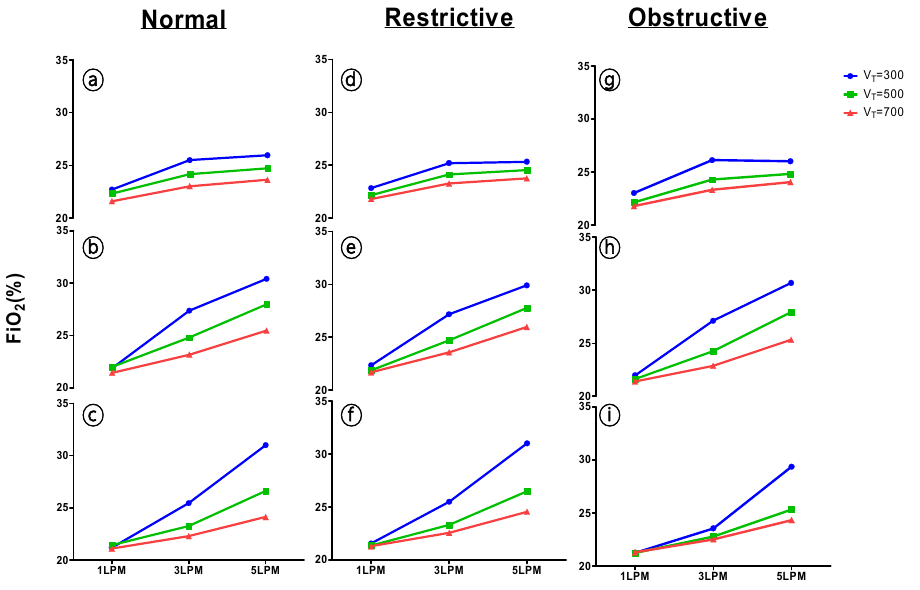
Figure 3. Effect of tidal volume (V T ) on FiO 2 . ( a , d , g ) RR: 10 breaths/min.; ( b , e , h ) RR: 20 breaths/min.; ( c , f , i ) RR: 30 breaths/min.